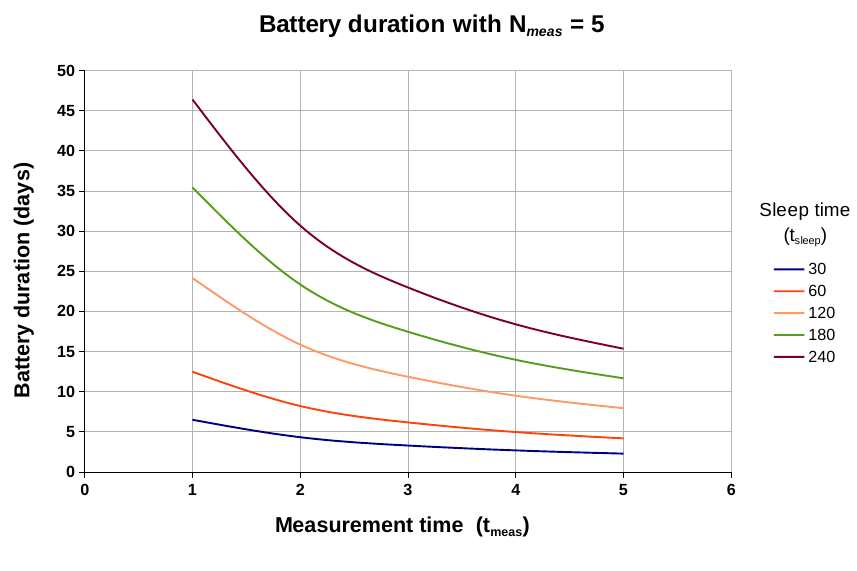
Figure 15. Estimated duration of a 750 mAh battery, keeping the number of measurements between uploads ( N meas ) equal to 5, as a function of t meas and t sleep